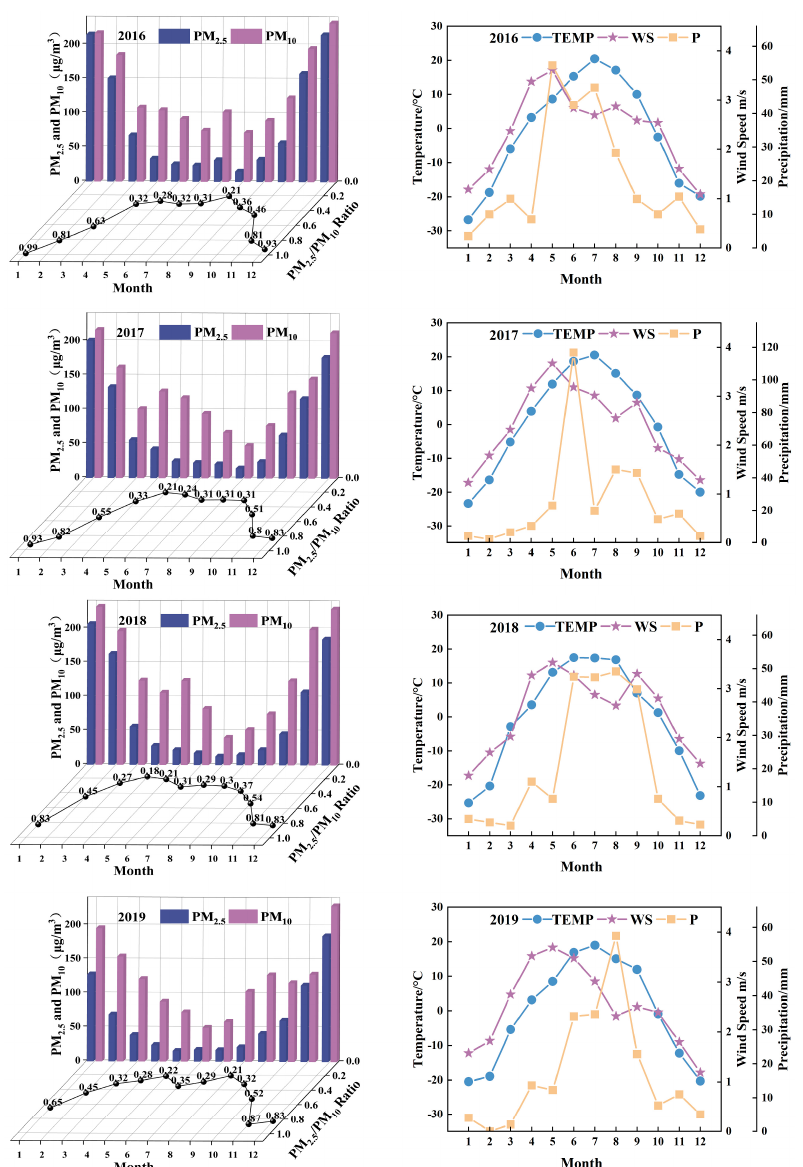
Figure 6. Monthly changes in pollutants and meteorological parameters (TEMP: temperature, WS: wind speed, P: